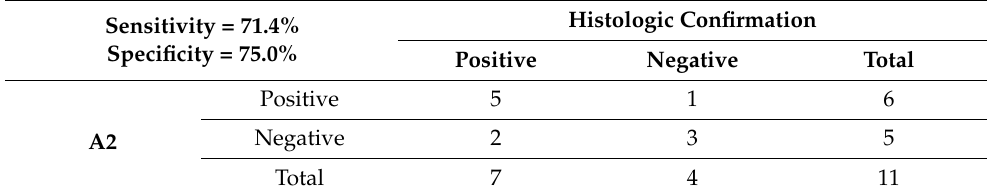
Histologic Confirmation